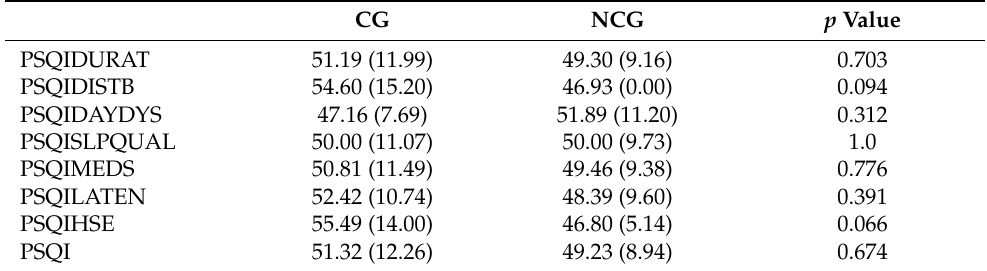
Table 3. Mean t-scores (SD) for caregivers (CG) and non-caregivers (Non-CG) on the PSQI